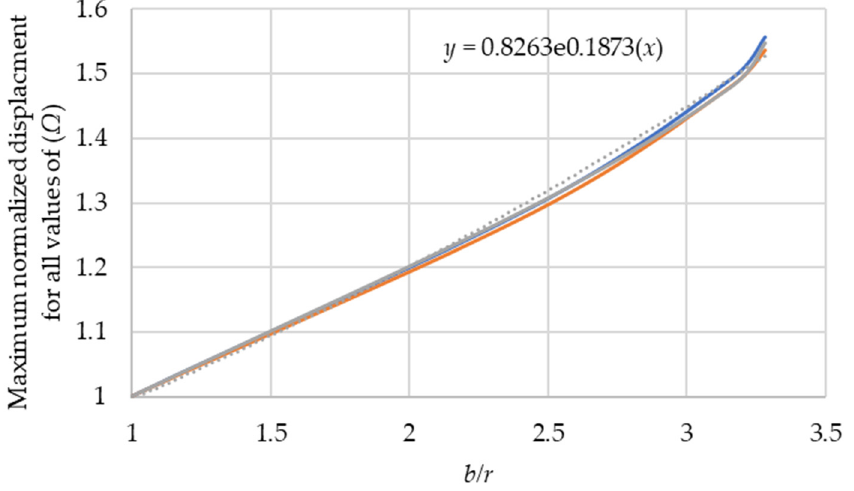
Figure 18. De la Llera Juan C. and Chopra Anil K. [6] proposed design factor to calculate normalized edge displacement, ( A t ).